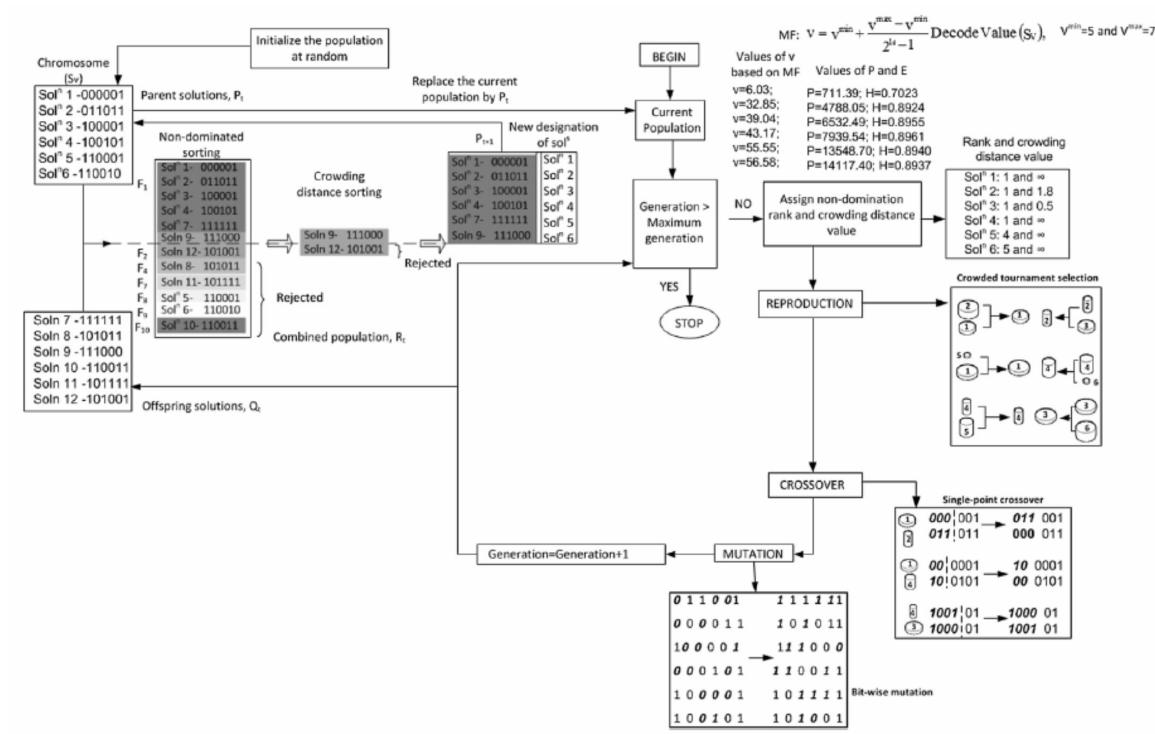
Figure 2. Schematic representation of binary-coded NSGA-II for a two-objective problem having one decision